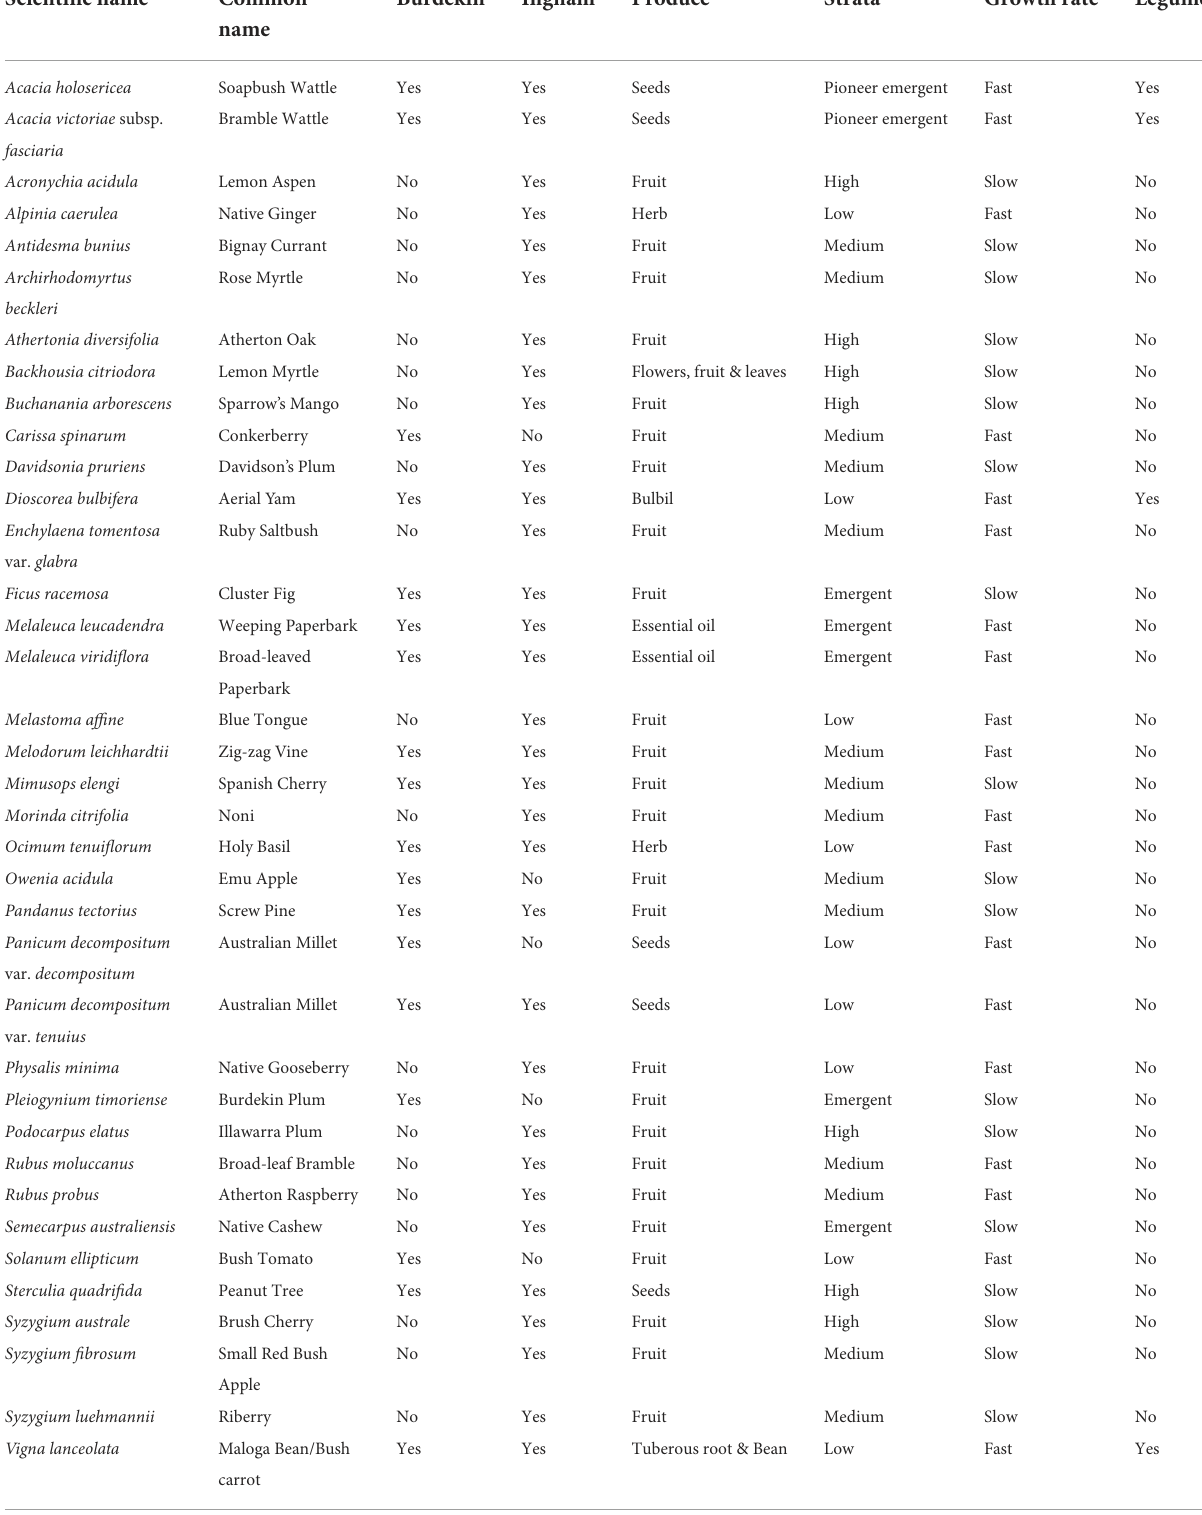
TABLE 3 Bush food species predicted to be widely suitable across the sugarcane-growing areas of the Burdekin (dry tropical climate) and Ingham (wet tropical climate) regions of the Great Barrier Reef catchment, along with the type of edible produce, approximate forest strata position, indicative growth rate, and whether the species is a